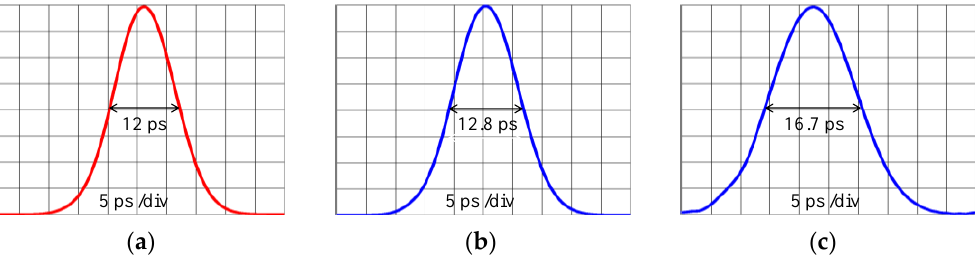
Figure 4. Simulations of the recovered OCDMA auto-correlation S L;T envelope by the OCDMA decoder: ( a ) for L = 19.5 km and T = 20 ° C the FWHM width = 12 ps; ( b ) for L = 19.5 km and T = 50 ° C the FWHM width = 12.8 ps; and, ( c ) for L = 40 km and T = 80 ° C the FWHM width = 16.7 ps.